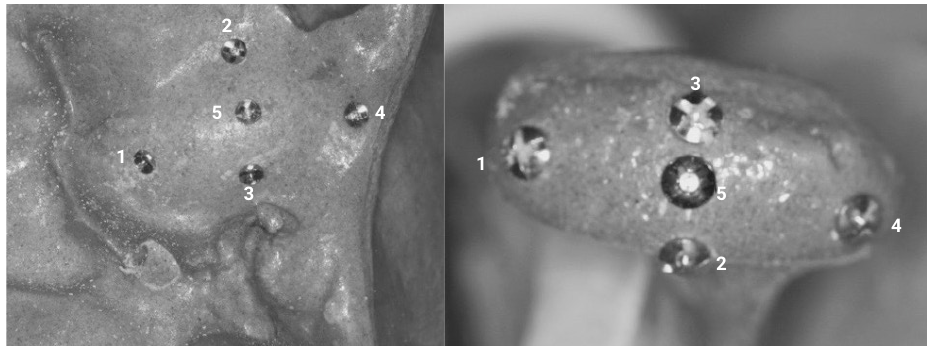
Figure 1. Metallic markers at the medial (1), anterior (2), posterior (3) lateral (4) and central (5) positions of the glenoid glenoid fossa and